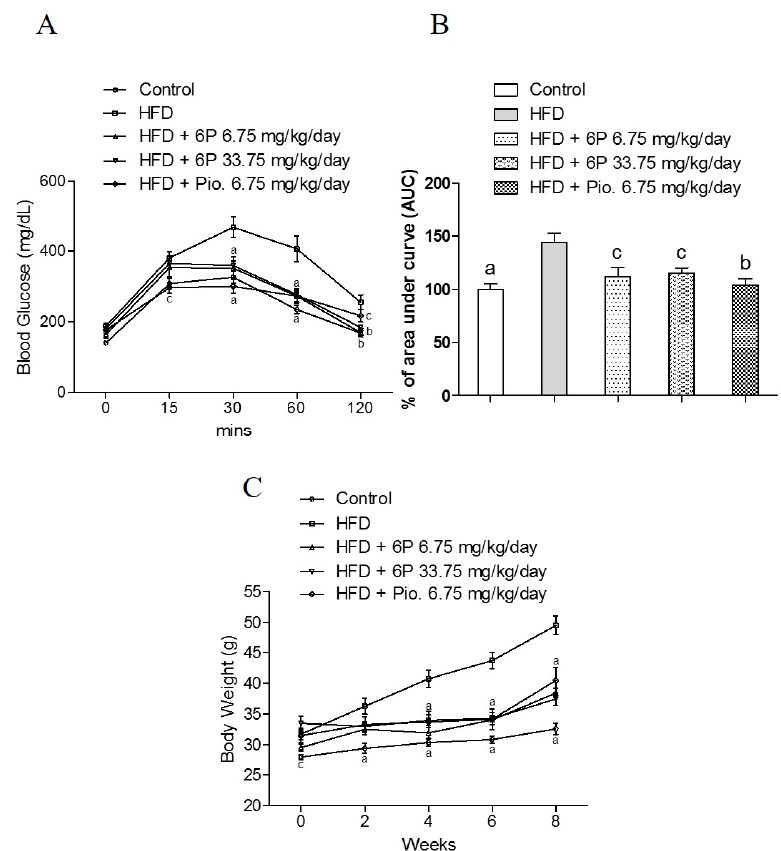
Figure 6. 6-Paradol alleviates blood glucose and body weight in high-fat diet-fed mice. ( A ) Effect of 6-paradol on glucose tolerance in mice fasted for 2 h as determined by the oral glucose tolerance test (OGTT); ( B ) area under the curve (AUC) for the OGTT test; ( C ) body weight within eight weeks. Data reflect the mean ± SEM of three independent experiments. a p < 0.001, b p < 0.01 and c p < 0.05 indicate a significant difference compared with the HFD group. Control represents the group of normal- diet-fed mice ( n = 9); HFD represents the group of high-fat diet-fed mice ( n = 8); HFD + 6P 6.75 mg/kg/day represents the group of high-fat diet-fed mice fed with the 6-paradol (6.75 mg/kg/day) treatment ( n = 7); HFD + 6P 33.75 mg/kg/day represents the group of high-fat diet-fed mice fed with the 6-paradol (33.75 mg/kg/day) treatment ( n = 6); HFD + Pio. 6.75 mg/kg/day represents the group of high-fat diet-fed mice fed with the pioglitazone (6.75 mg/kg/day) treatment ( n = 6).